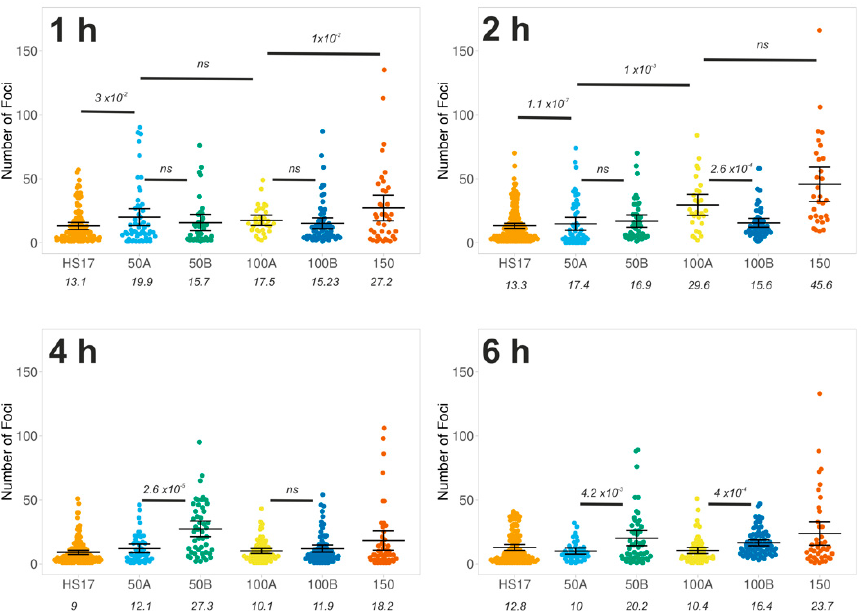
Figure 3. Quantification of DNA damage foci. Quantitative image analysis, as described in the Methods Section, from the experiments in Figure 2. Foci were determined based on staining of γ H2AX. The number of foci per nucleus is plotted for each crRNA (Table 1). Each data point is an individual nucleus. The p -value is calculated from a two-tailed t -test and the error bars represent standard deviation (SD). The mean values are presented.